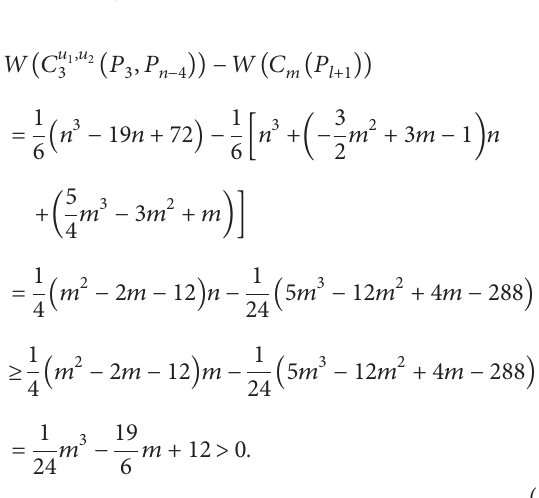
( T ( n − 5 , 1 , 1 )) (a) and C 3